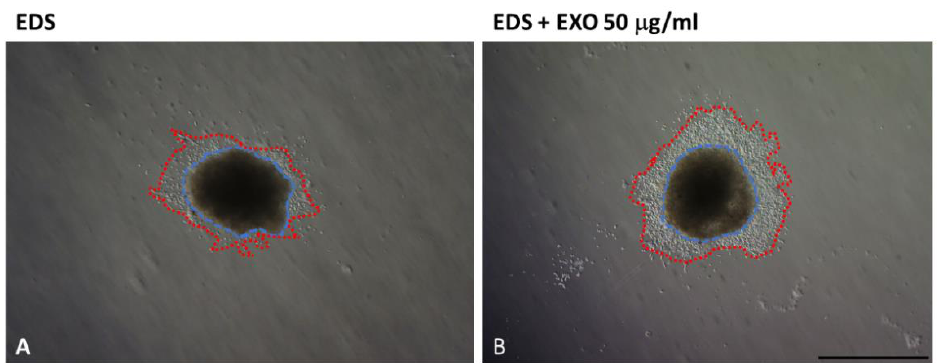
Figure 5. Melanoma cells migrate from the heterogeneous spheroids prepared from melanoma CAFs and melanoma cells ( A , B ). Melanoma-derived CaExo treatment facilitated migration ( B ). The blue circle demonstrates the position of the original spheroid, and the red circle highlights the leading edge of migration. To follow only the influence of melanoma-derived exosomes, the 3D collagen gel and culture medium contain only exosome-depleted serum. Bar represents 1 mm.